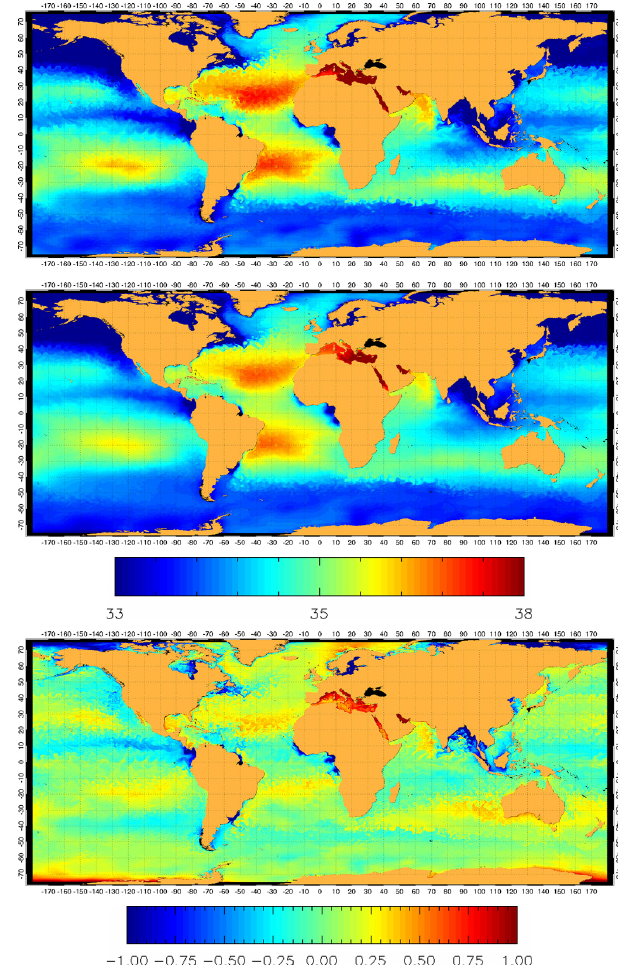
Fig. 5. Top: Original SSS. Middle: SSS map after filtering using the SST map as a template. Bottom: Map of